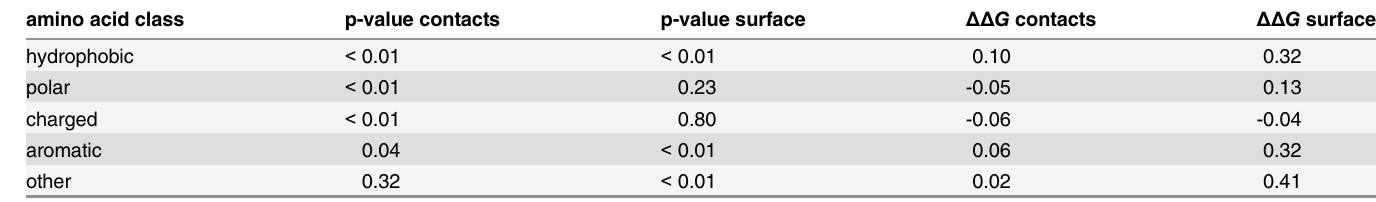
Table 3. Significance of hydrophobic temperature dependence pooled. amino acid